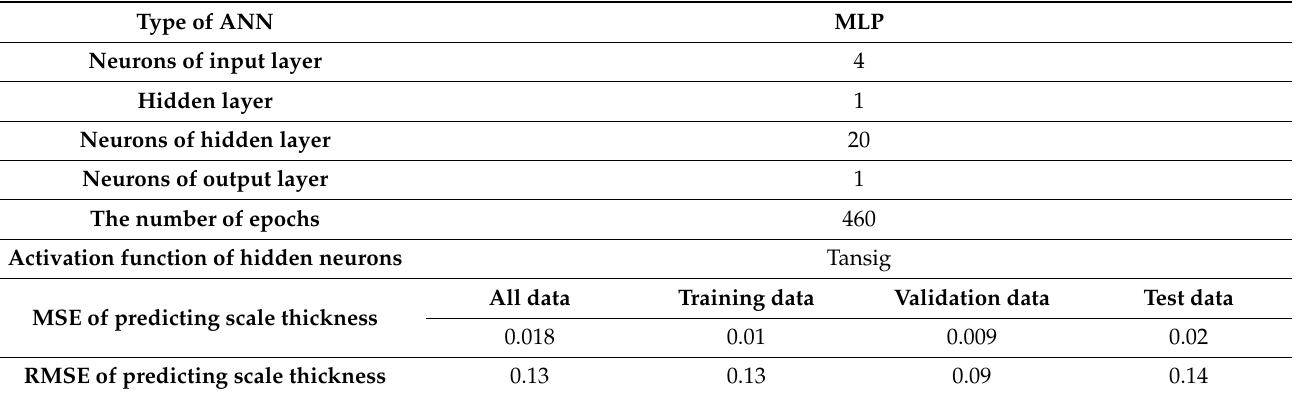
Table 1. The details of the trained MLP